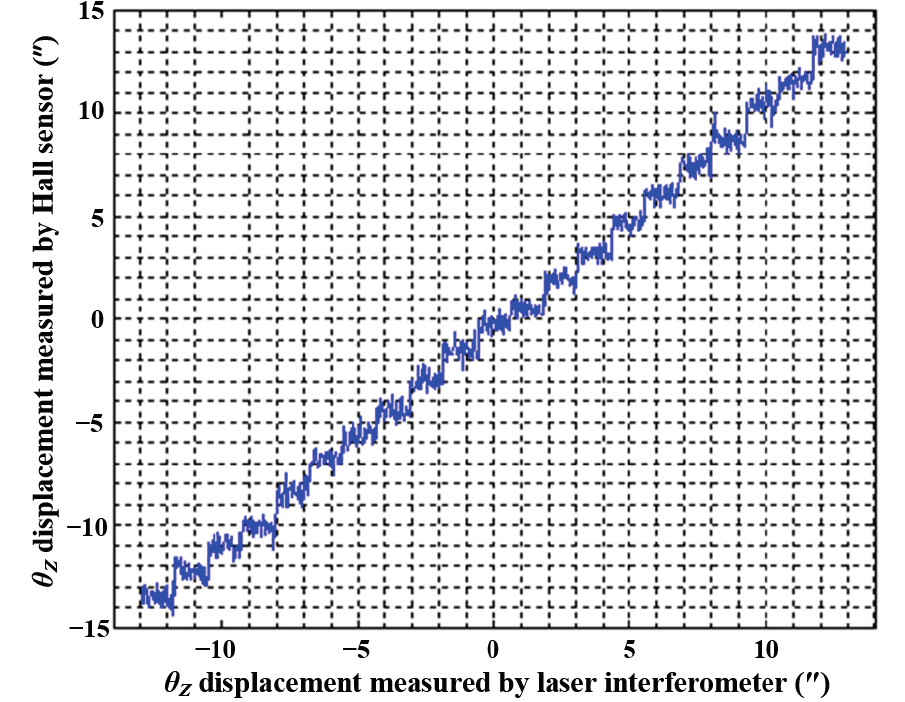
Figure 17. The resolution of the Hall sensors in θ Z